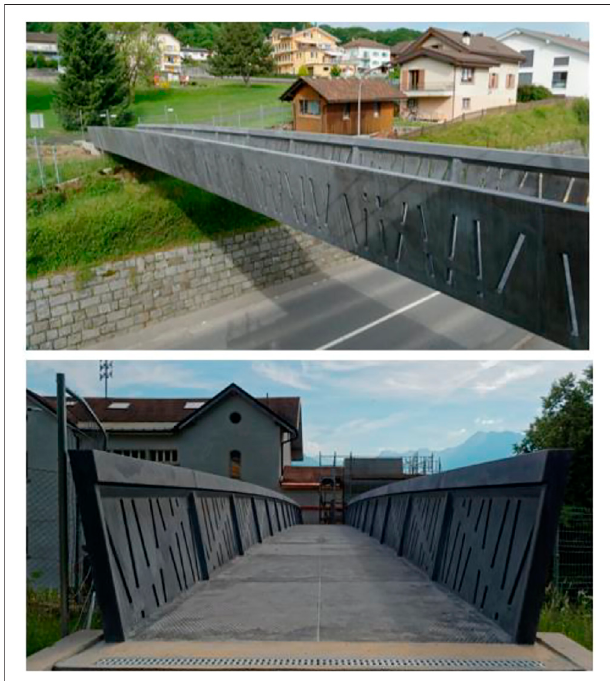
FIGURE 12 | Bouveret footbridge. (Photographs: P.